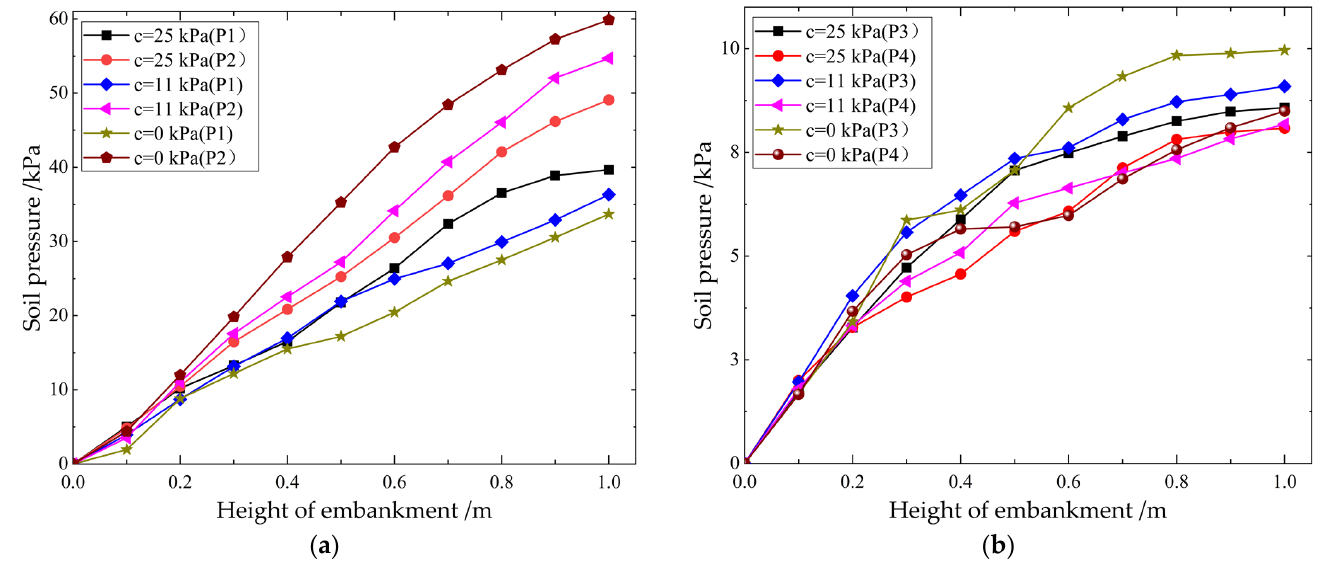
Figure 6. Variation in soil pressure at the embankment’s bottom, ( a ) soil pressure above pile cap; ( b ) soil pressure above subsoil.